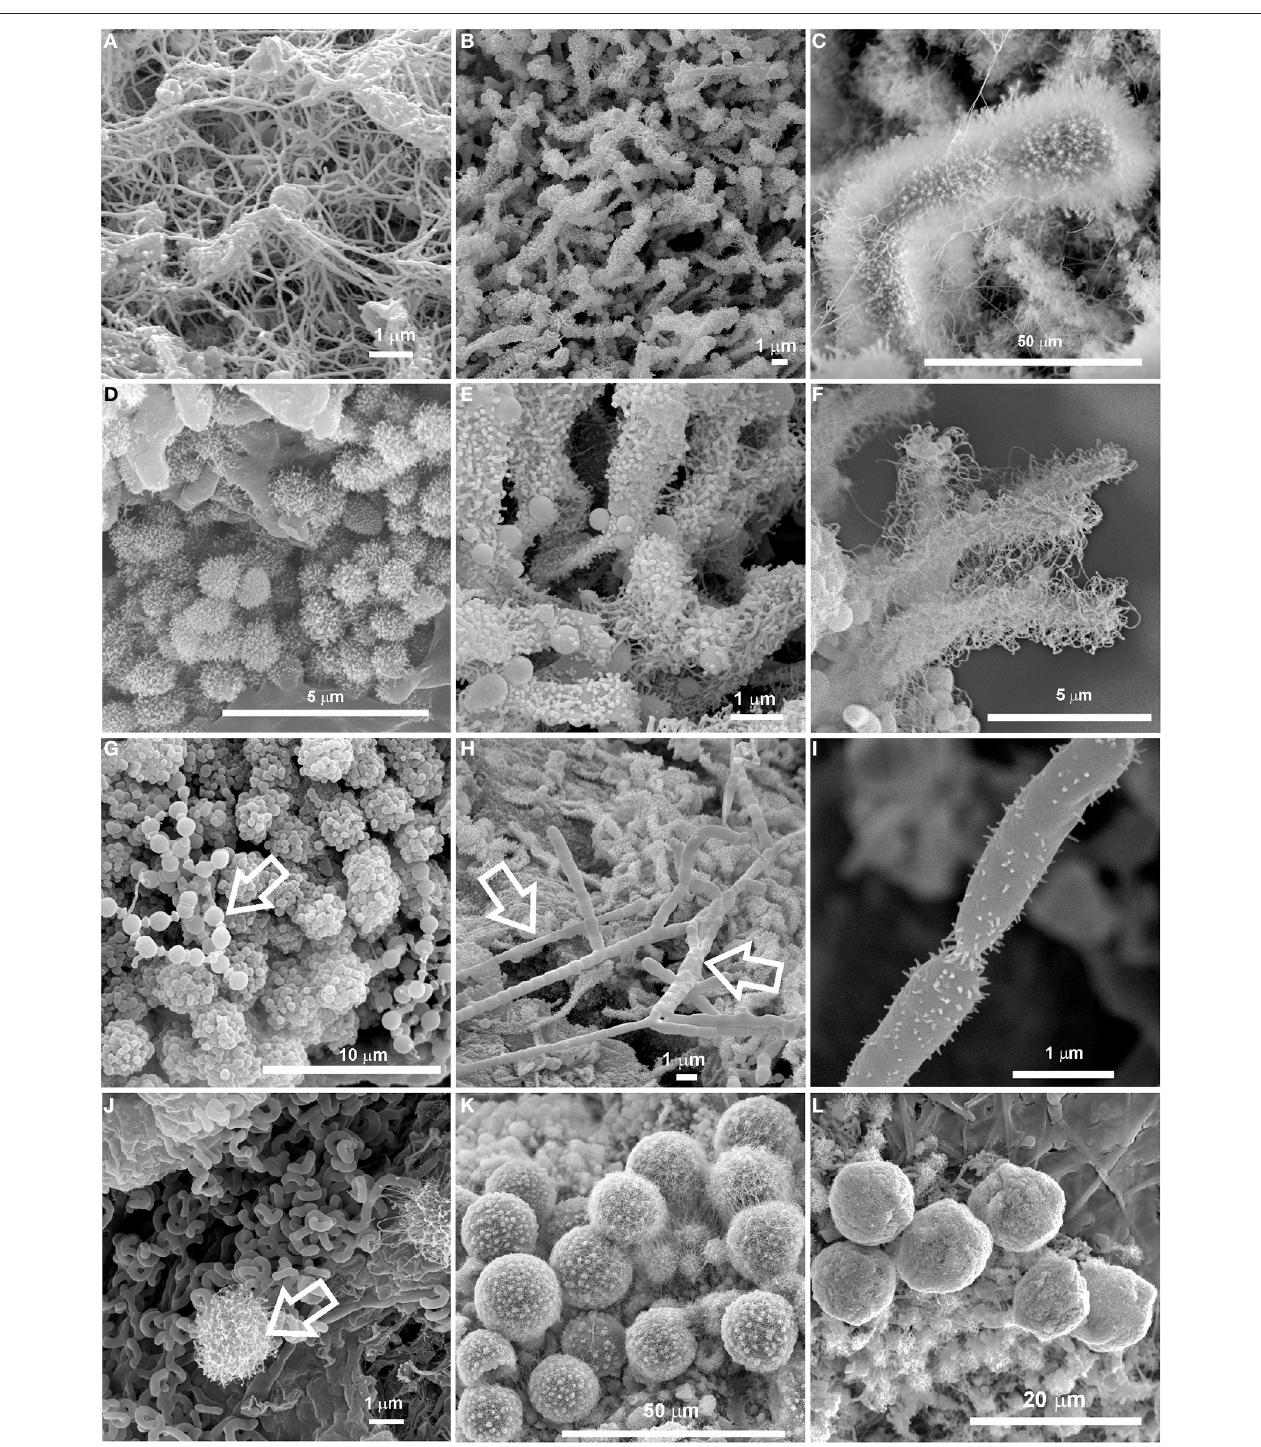
FIGURE 2 | SEM images of colored microbial mats found in Azorean, Canadian, Canarian, Hawaiian and New Mexican volcanic caves showing a large variety of microbial morphologies and spore surface ornamentation. (A,B) Dense network of interwoven filaments in Honda del Bejenado and Fuente de la Canaria caves (La Palma Island, Spain); (C) Dense masses of Streptomyces -like spore chains with hairy ornamentation from Cave 12 in El Malpais National Monument (New Mexico, U.S.A.); (D) Coccoid cells with surface appendages or obtuse protuberances from Gruta da Terra Mole (Terceira Island, Azores, Portugal); (E) Detailed view from (B) showing coccoid cells and clumps of spore chains with obtuse protuberances and surface appendages; (F) Close-up view of clusters of Streptomyces -like spore